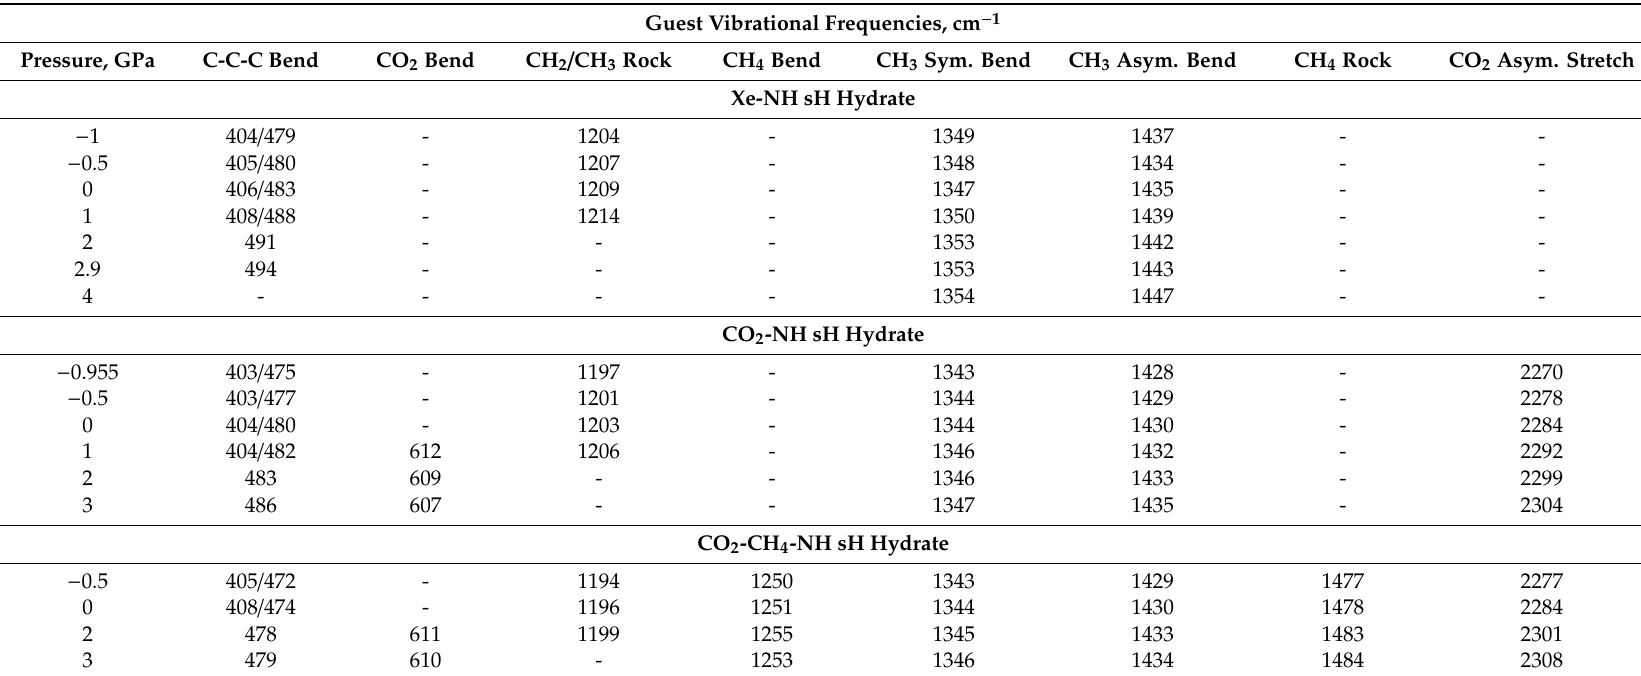
Table 5. Pressure dependence of guest vibrational frequencies in sH gas